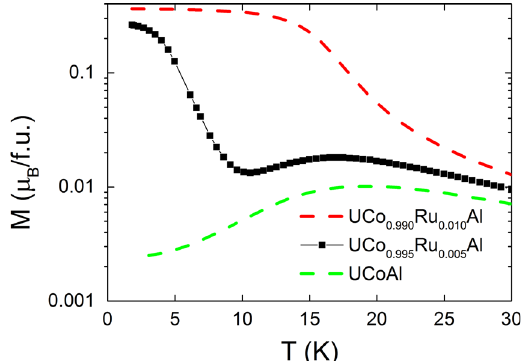
Fig. 1 Temperature dependence of the low- fi eld (0.1T applied along the c -axis) magnetization for UCo 0.995 Ru 0.005 Al, UCo 0.990 Ru 0.010 Al and UCoAl. Logarithmic scale (vertical axis) is used to visualize features connected with spin- fl uctuations